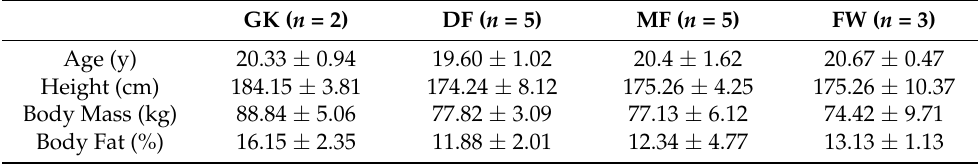
Table 1. Means and standard deviations of selected characteristics by player